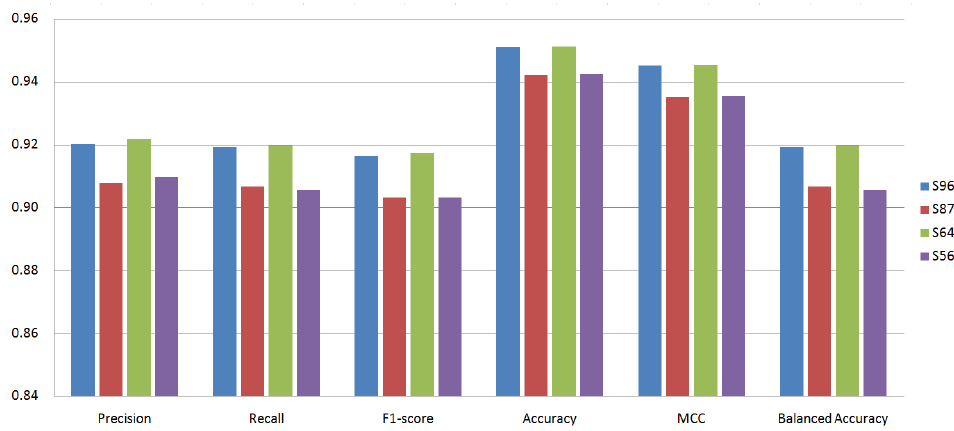
Figure 8. Performance of LightGBM for each permission